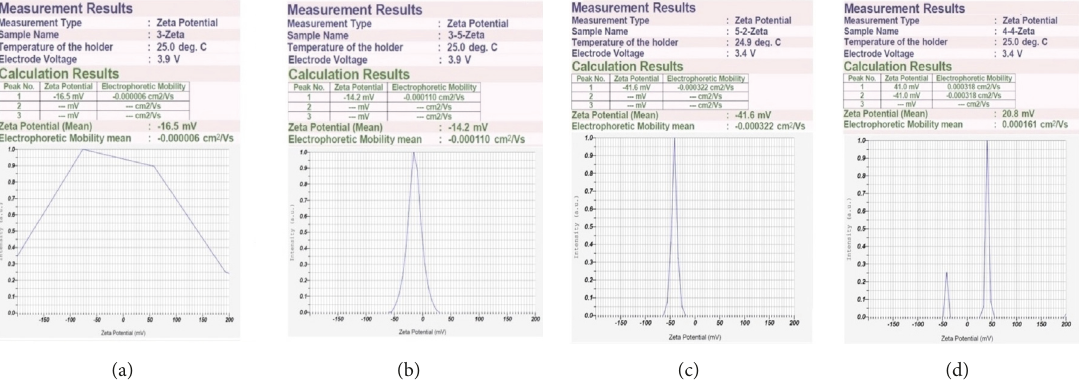
Figure 6: Zeta potential variation of nanofluids during 60 days. (a) Lubricants with long MWCNTs immediately after preparation, (b) lubricant with long MWCNTs after 60 days, (c) lubricant with 5-hour ball-milled MWCNTs immediately after preparation, (d) lubricant with 5-hour ball-milled MWCNTs after 60